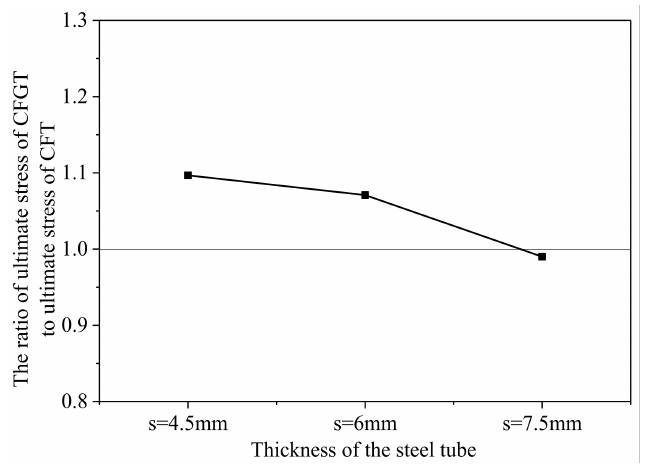
Figure 8. Strength ratio of concrete confined with steel tubes with grooves and without